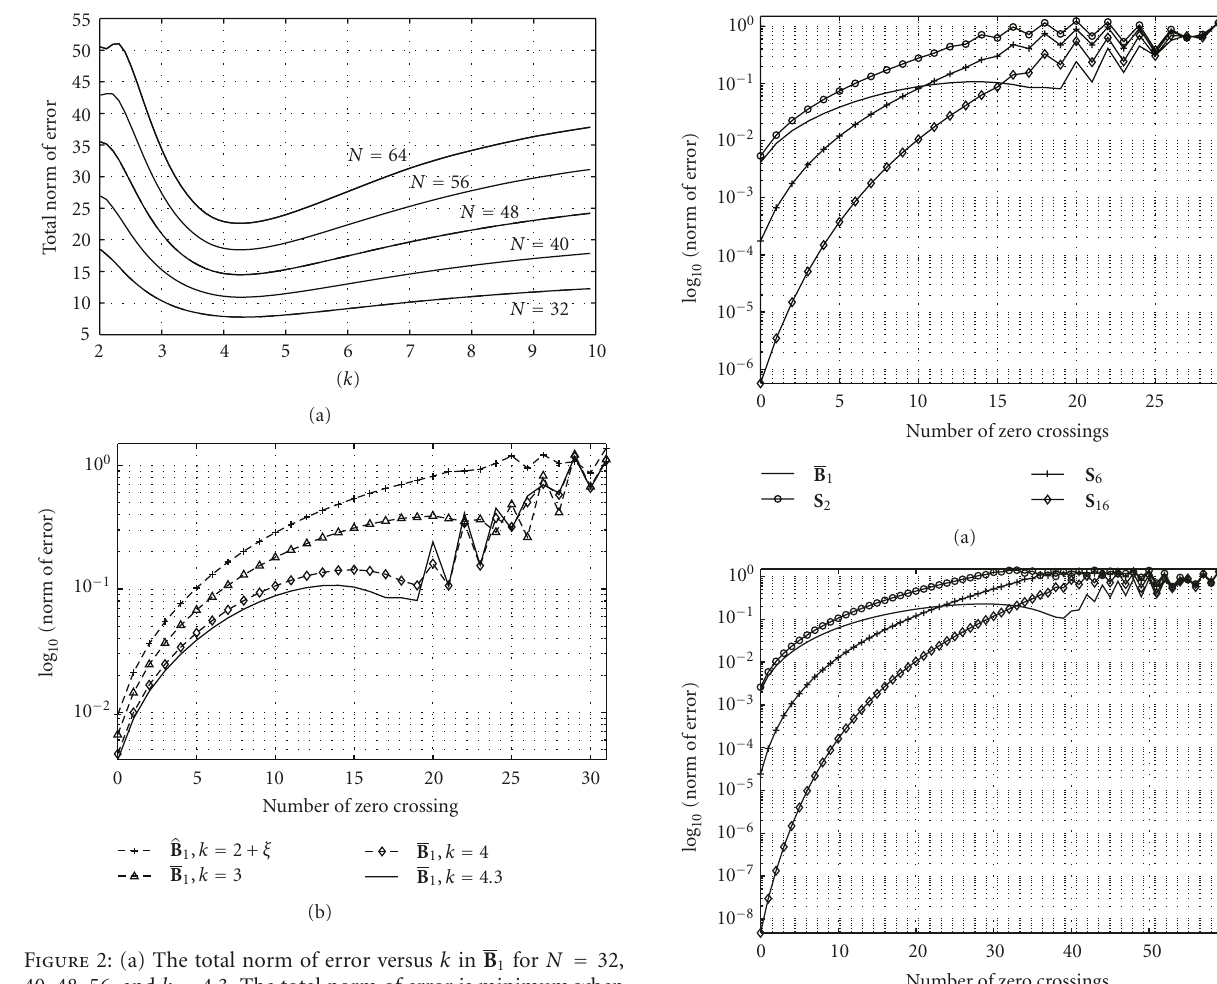
versus k for di ff erent values of N , and the best value for k is approximately 4 .